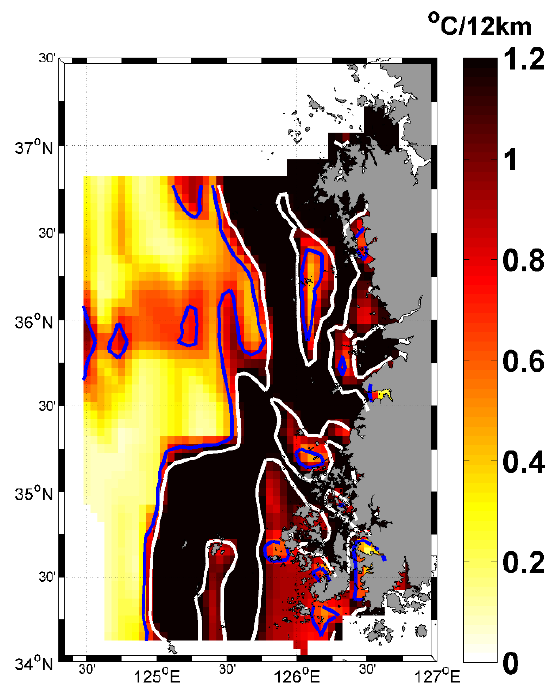
Figure 14. Horizontal gradient of surface temperature for June from 2010 to 2013. The unit of the temperature gradient is ◦ C / 12 km. Blue and white contours represent 0.7 and 1.2 ◦ C / 12 km, respectively.